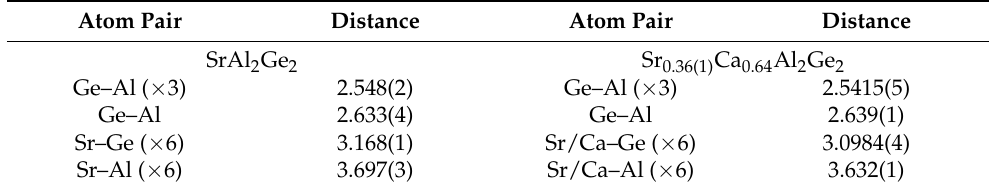
Table 4. Selected interatomic distances (Å) in SrAl 2 Ge 2 and Sr 0.36(1) Ca 0.64 Al 2 Ge 2 . Shortest metal– metal contacts are equal to the a -lattice vector (longer than 4.2 Å) and are not